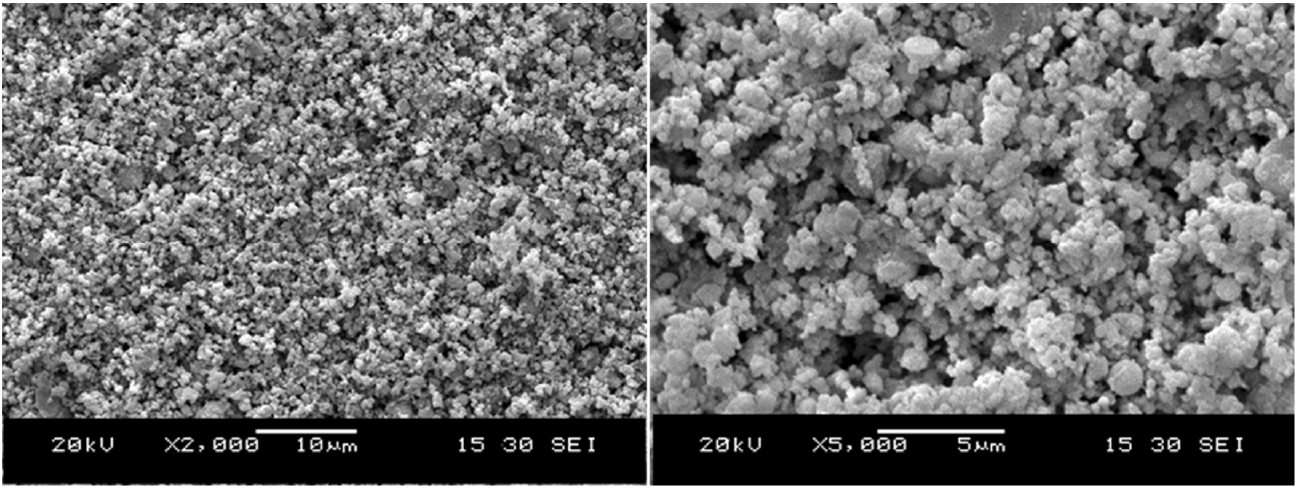
Figure 4. SEM micrographs of the electric furnace flue dust at 2000 magnifications ( left ) and 5000 magnifications ( right ).